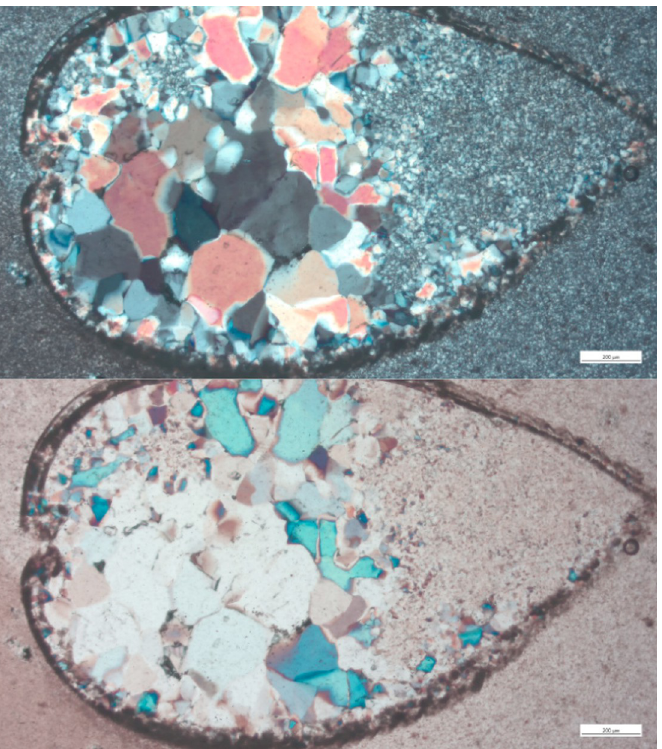
Fig 19. An oval ostracod observed in one of the Mishash flint samples, in cross polars (above) and in plain polars (below), infilled with large grains of quartz.